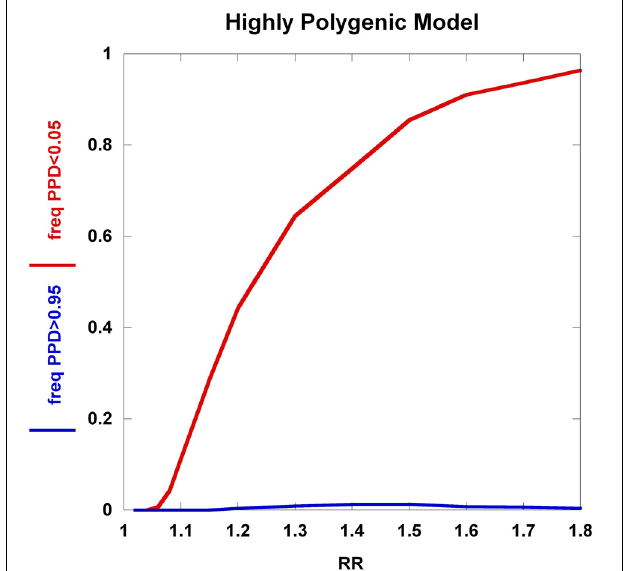
FIGURE 7 | Highly penetrant model. The highly penetrant model uses 100 SNPs each having a predisposing genotype frequency of 0.1% and also a prior probability of 0.20. The relative risk takes on values from 10 to 400. Although the highly polygenic model yields a large proportion of individuals with posterior probabilities below 0.05, the increasing relative risks have little impact on the proportion of individuals with posterior probabilities above 0.95. The highly penetrant model shows an overall increase in the proportions of individuals with posterior probabilities below 0.05 and above 0.95, but the patterns are somewhat unexpected (not smooth, nor monotone). These patterns are generated from all predisposing SNVs having identical genotype frequencies and relative risks, coupled with having specific PPD